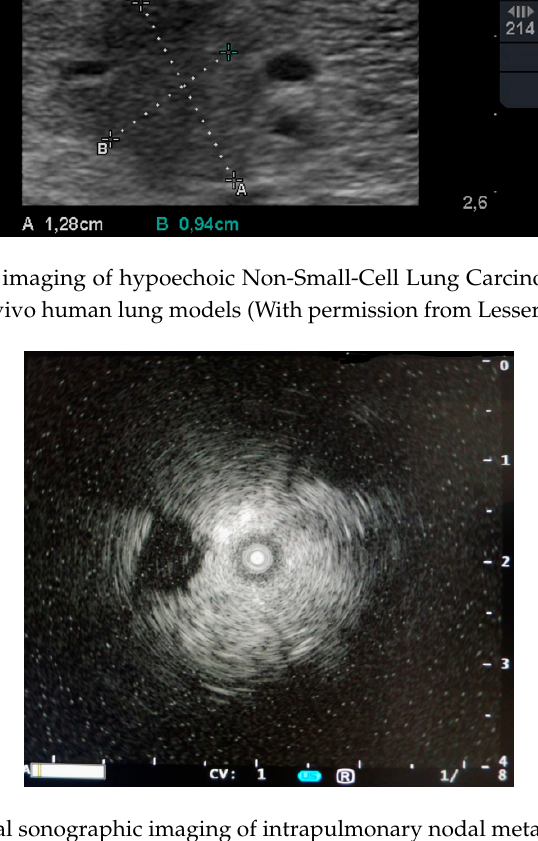
Figure 7. Endobronchial sonographic imaging of intrapulmonary nodal metastasis in saline flooded lung using ex-vivo human lung models.